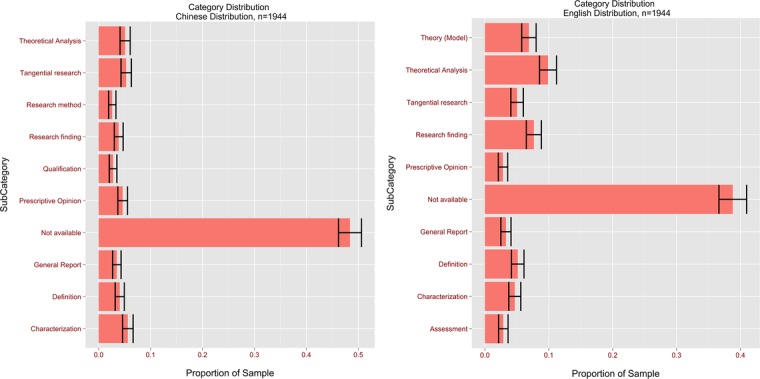
Proportions of all English and Chinese citation type distributions with confidence bars.